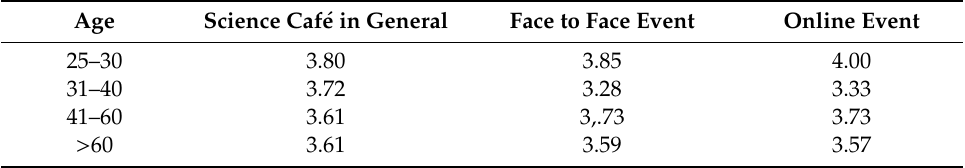
Table 3. Average approval of the various modalities per age class. Votes range from 1 (not good) to 4 (optimum).